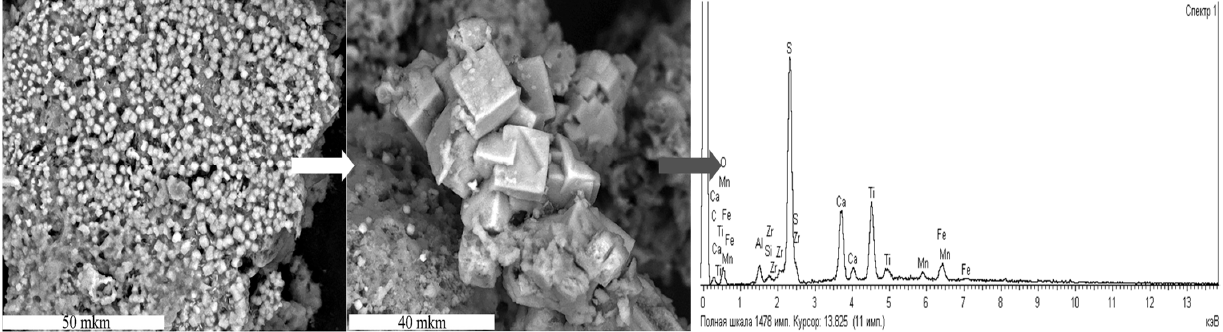
Figure 5. Cubic or pseudocubic crystals of CaTi(SO 4 ) 3 .